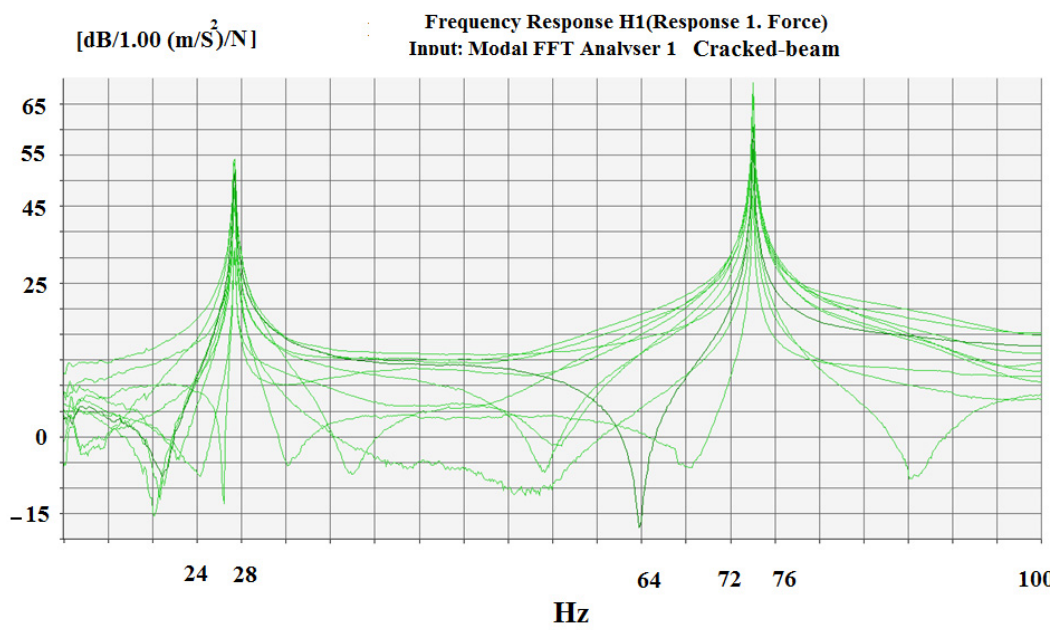
Figure 16. The frequency response functions obtained for the damaged beam.